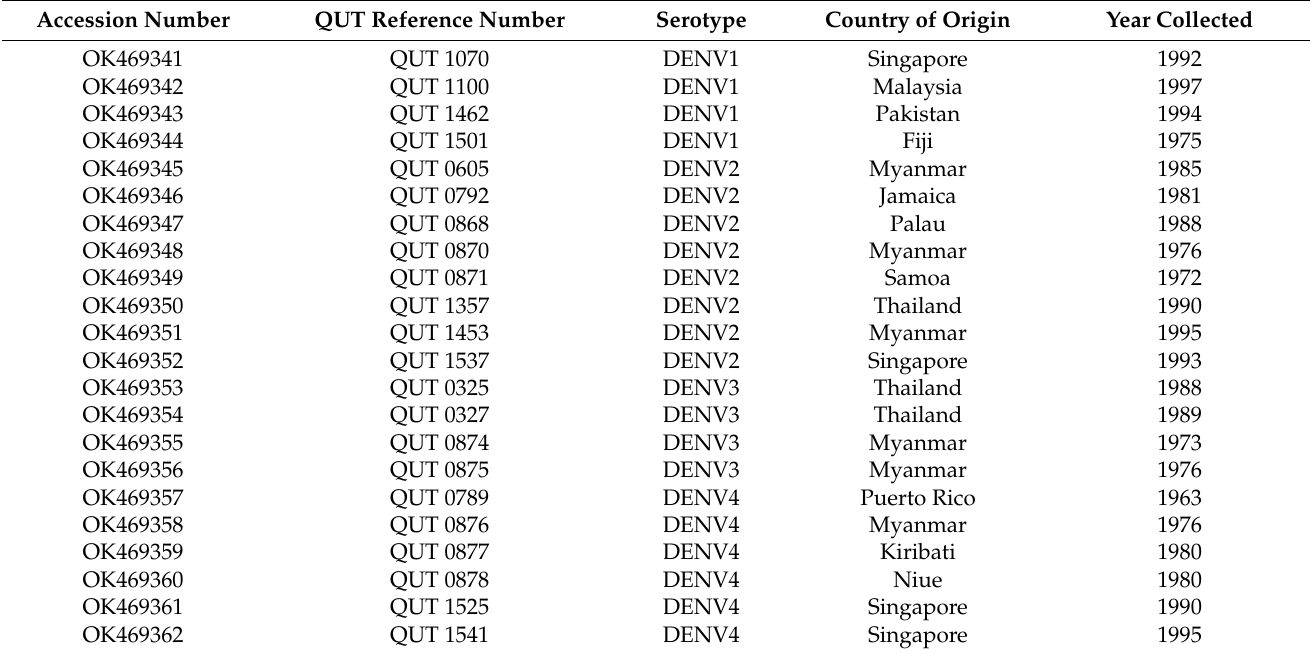
Table 1. DENV isolates sourced for this study from the QUT Arbovirus Collection (formerly a WHO Arbovirus Collaborating